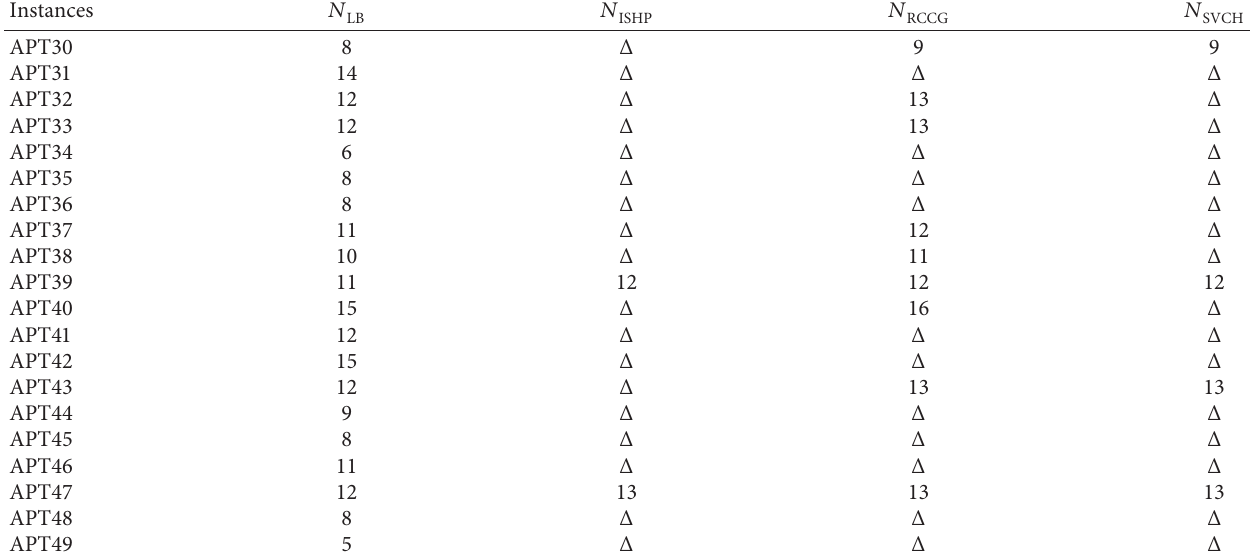
Table 3: Computational results for set B .